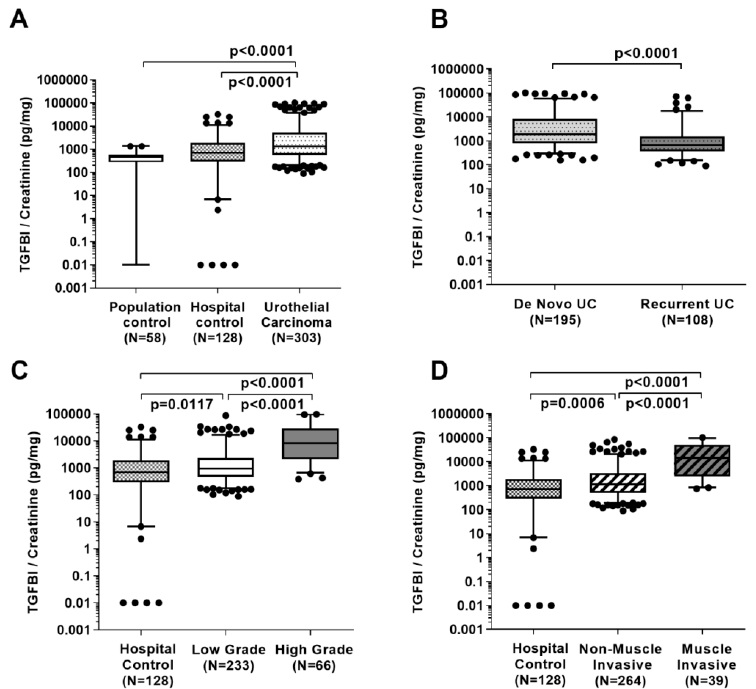
Figure 1. Creatinine-normalized TGFBI concentration in the urine of urothelial carcinoma (UC) patients, and hospital and population controls ( A ), in de novo UC patients and those with recurrent UC ( B ), in hospital controls compared to patients with low and high-grade UC ( C ) and compared to non-muscle invasive ( ≤ pT1) and muscle invasive UC ( > pT1) ( D ). Group di ff erences were calculated by Wilcoxon rank-sum tests